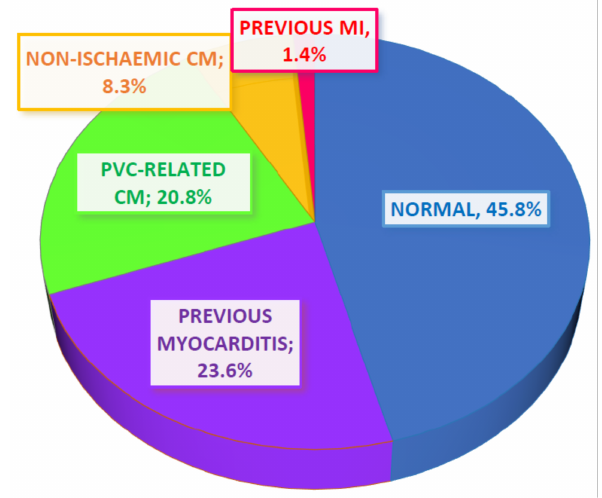
Figure 1. Pie chart showing the main categories of CMR diagnoses within the patient population. Most of the patients had normal CMR findings; myocarditis was the second most common diagnosis while a significant proportion of patients were characterised as having possible PVC-related car- diomyopathy. A small proportion of patients were diagnosed with non-ischaemic cardiomyopathy while only one patient had a myocardial infarction. CM: cardiomyopathy; MI: myocardial infarction; PVC: premature ventricular